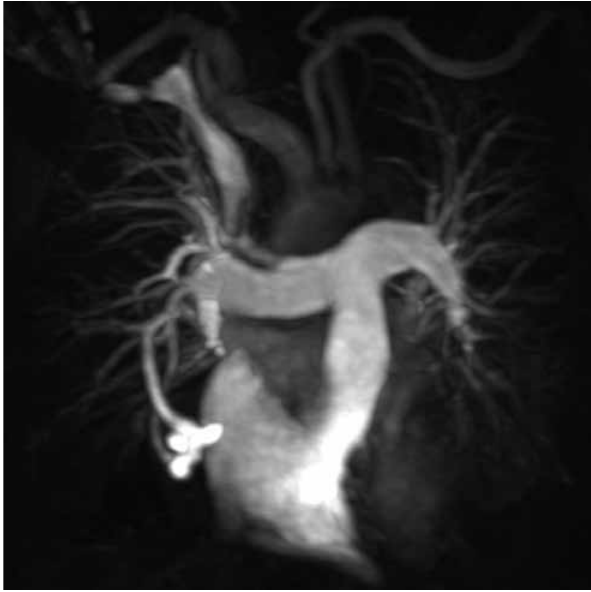
Figure 2: Pulmonary arteriovenous malformation on CE-MRA The CE-MRA scan shows a typical simple PAVM in the middle lobe. The diameter of the feeding pulmonary artery is 4